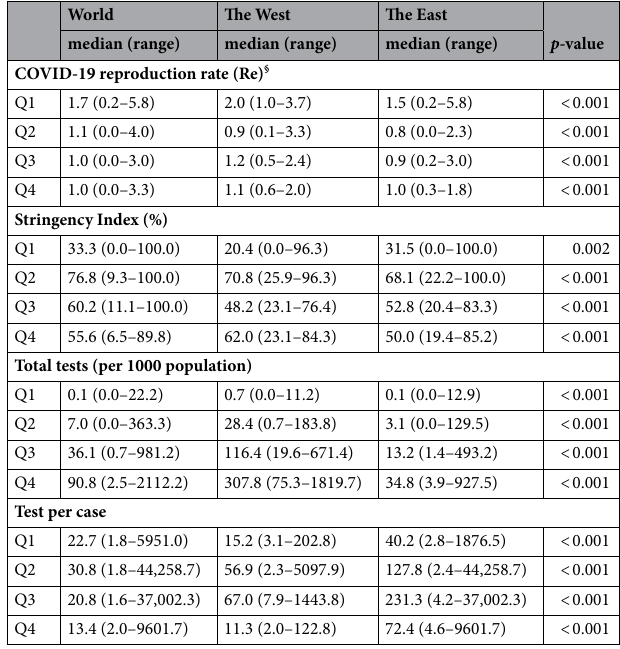
Table 4. COVID-19 Epidemiology and response during 2020. § COVID-19 Reproduction rate (Re) figures are the median values of the quarter within the region of interest, either the West or the East. A Mann–Whitney U test was used to test for differences between the West and the East. We had also performed a non-parametric test for trend across quarters (data not shown): p -values were < 0.001 for the World, the West and the East for all response variables expect for stringency index in the East ( p -value =